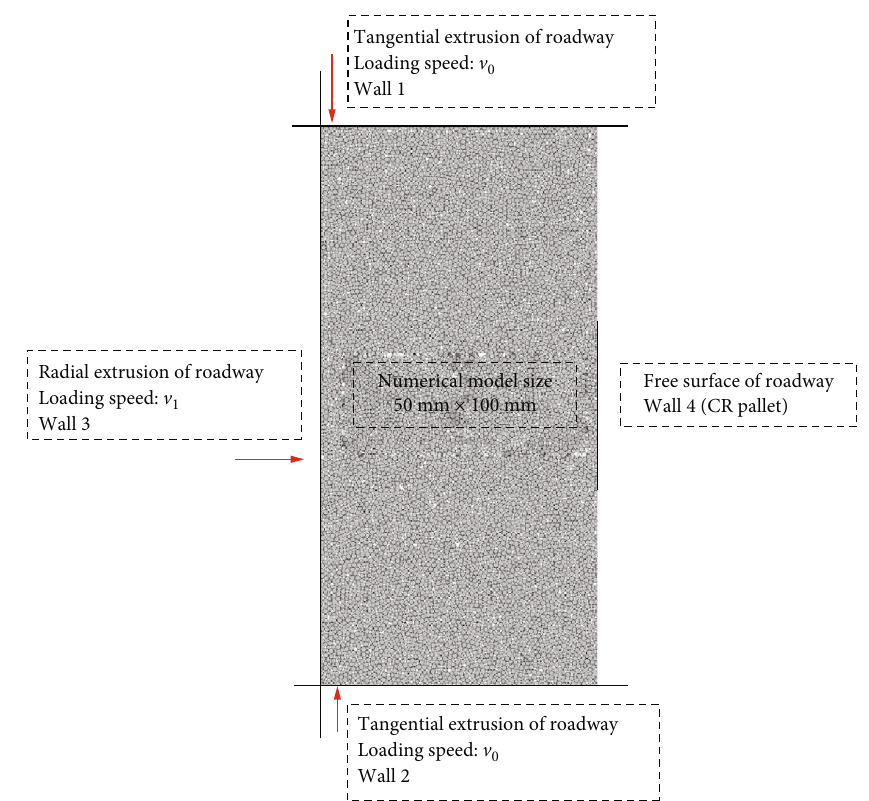
Figure 7: Numerical model and loading method.